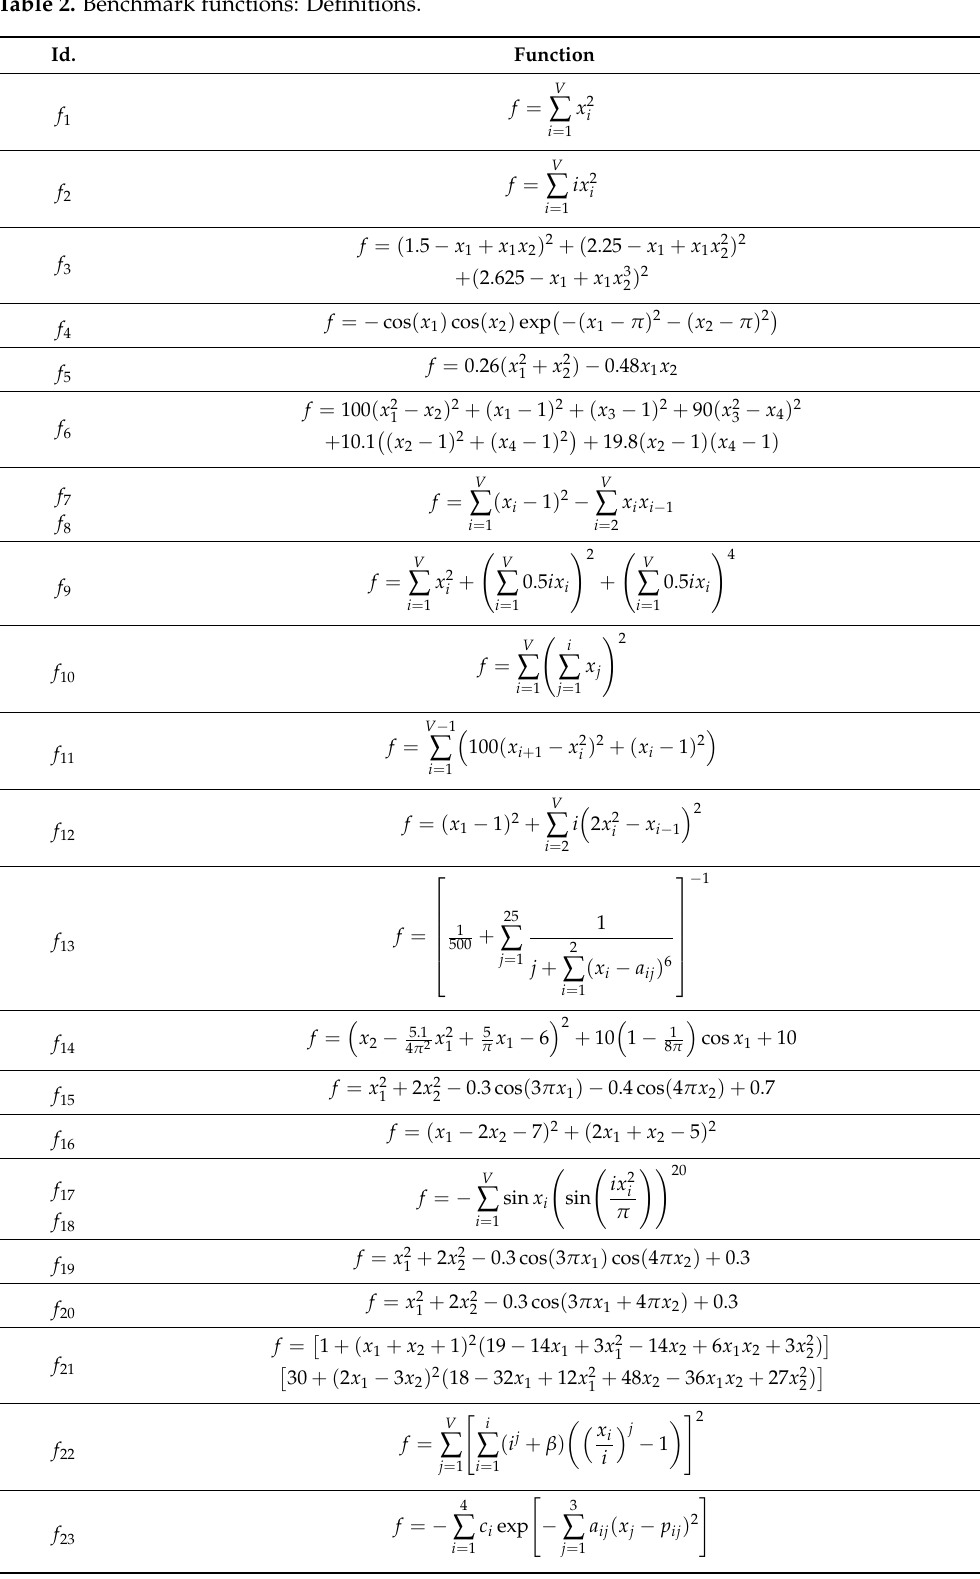
Table 2. Benchmark functions: Definitions.